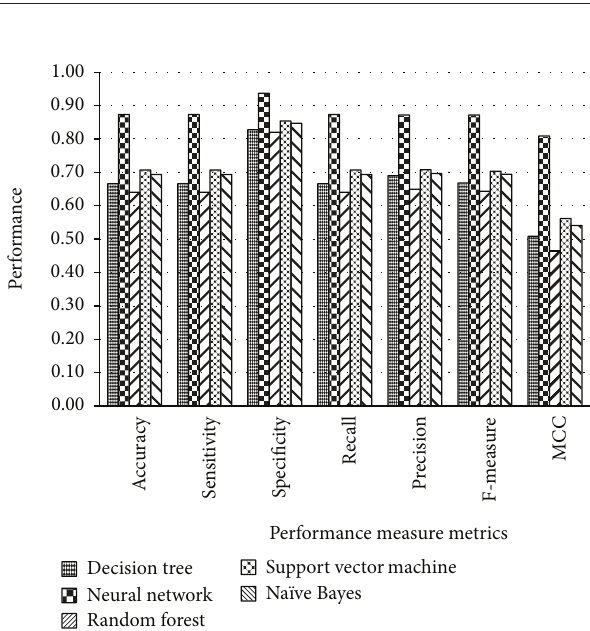
Figure 3: Comparison of the performance measure metrics using dataset